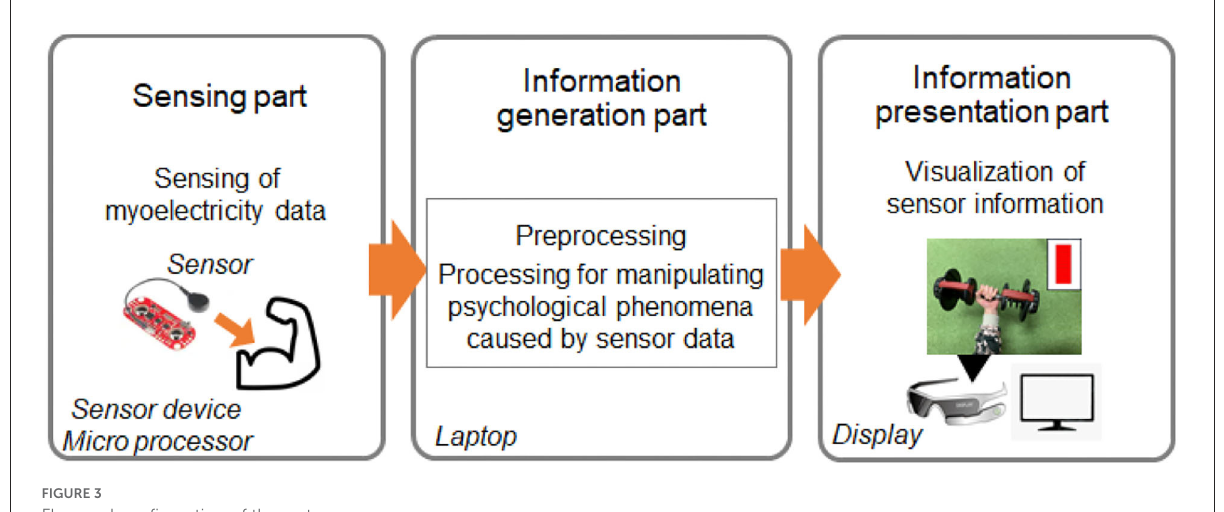
FIGURE3 Flow and configuration of the